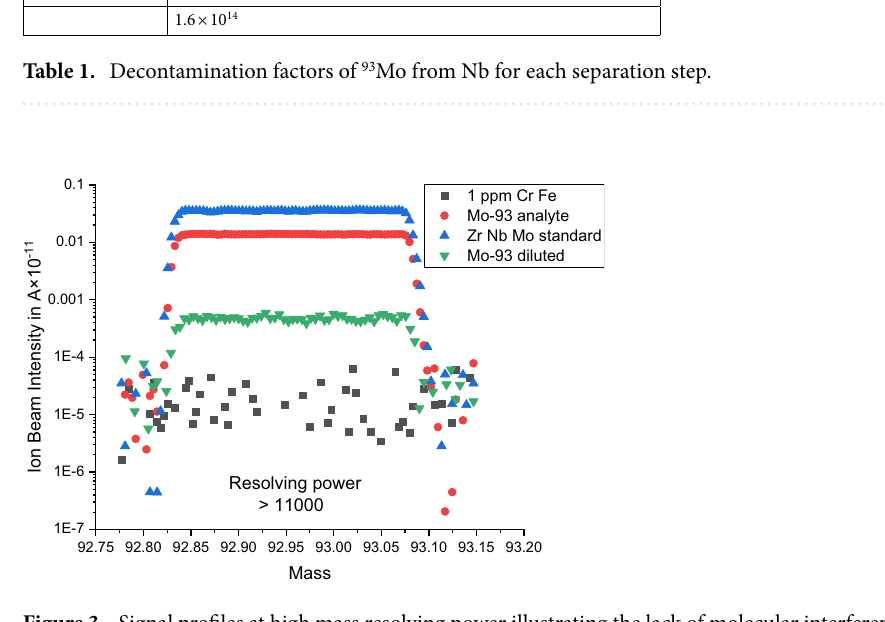
Figure 3. Signal profiles at high mass resolving power illustrating the lack of molecular interferences on mass 93 in the analyte. Molecular interferences whose mass difference to that of 93 Mo is smaller than the mass range of the scan would show (e.g., from low to high mass: 93 Mo-only, 93 Mo + + 53 Cr 40 Ar + , 53 Cr 40 Ar + -only) in the signal profile as prominent steps given the logarithmic scale. Further, note the lack of significant signal contributions from Metal Argides (MAr + ) at metal (Cr, Fe) impurities on the ppm